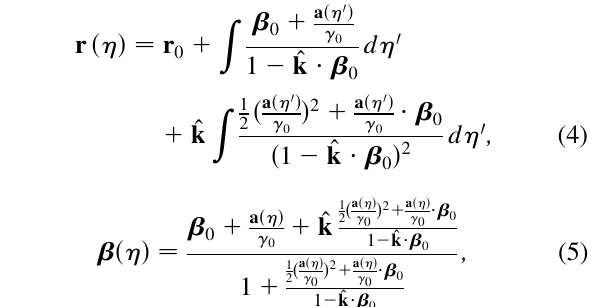
ffiffiffiffiffiffiffiffiffiffiffiffiffi 1 (cid:3) (cid:2)